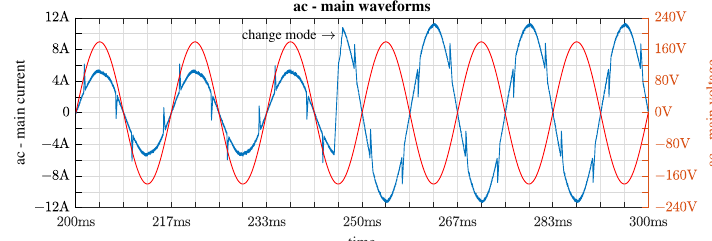
Figure 8. Ac-main electrical waveforms: current (blue) and voltage (red).